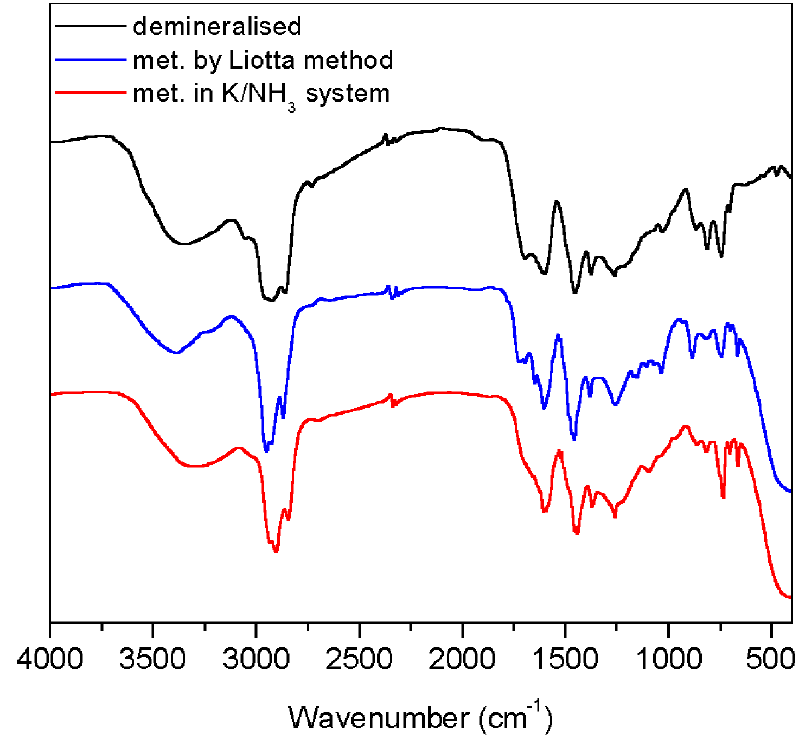
Fig. 2 IR spectra of CH 2 Cl 2 extracts of Illinois No. 6